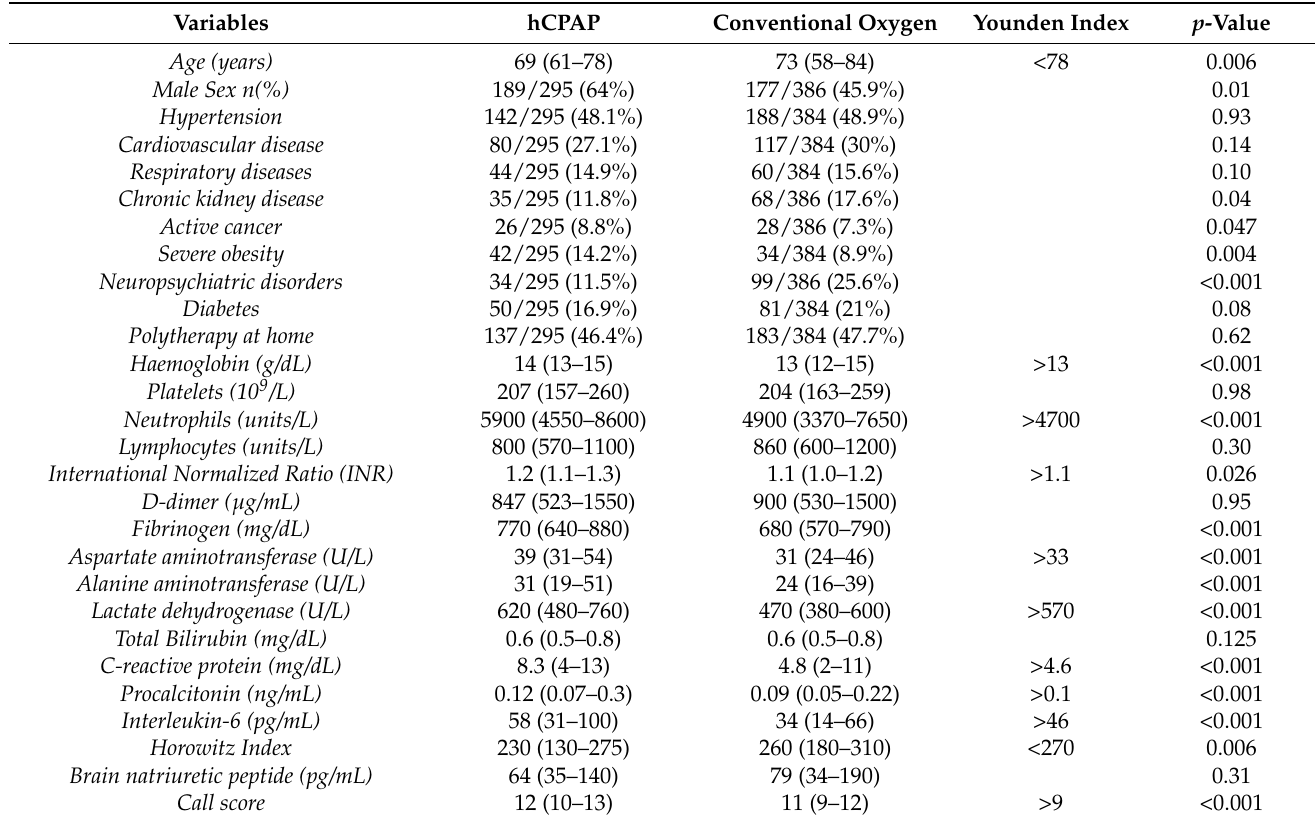
Table 1. Differences between patients treated with hCPAP and conventional oxygen